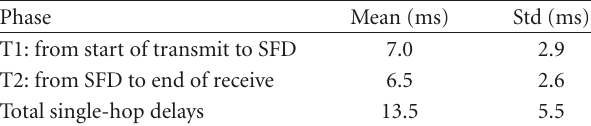
Figure 23: Single-hop delay model for sensor nodes. Table 3: Single-hop delays for sensor